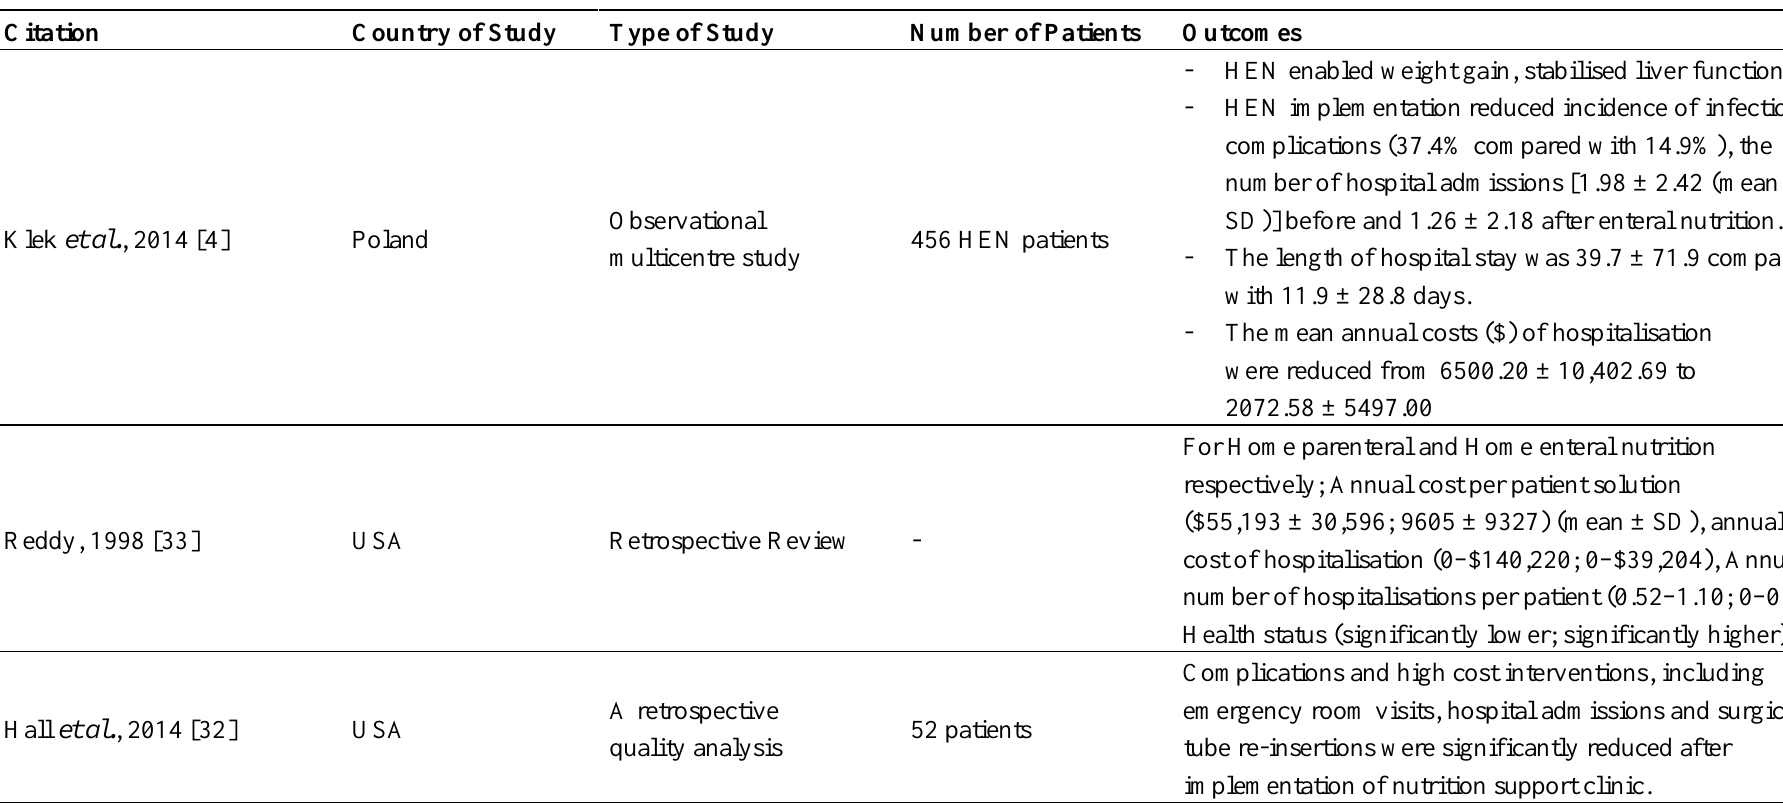
Table 2. The Cost—effectiveness of Enteral